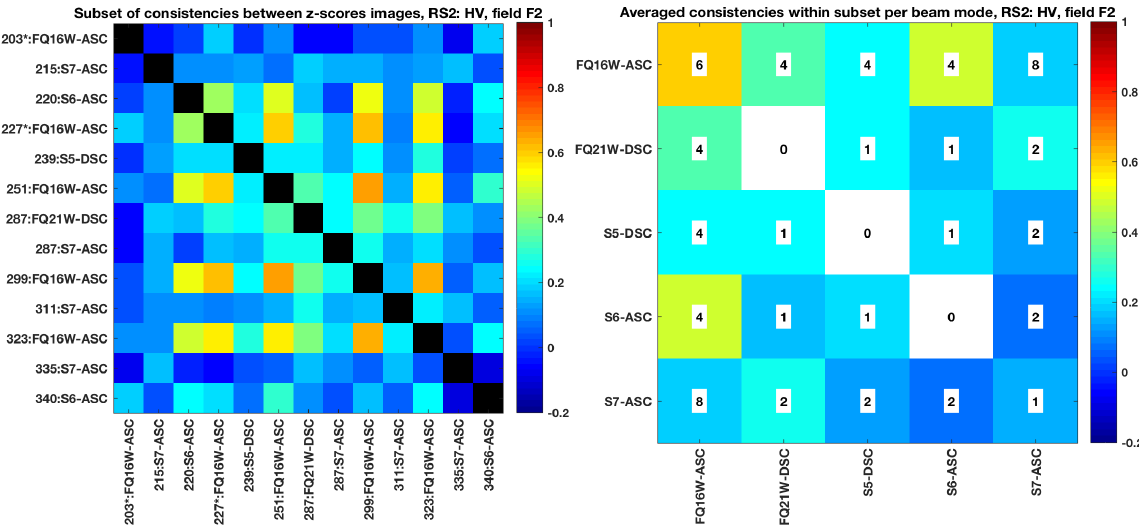
Figure 15. Subset of the RS2 HV consistency matrix of Figure 13 accompanied by beam-mode information ( left ). Both axes present days from start of growth and asterisks indicate which acquisitions were rain-affected. Diagonal values were omitted and colored black. In addition, averages of the consistencies between beams with the number of unique image pairs are displayed in each cell ( right ). White cells have no value as no image pair exists for those specific modes.